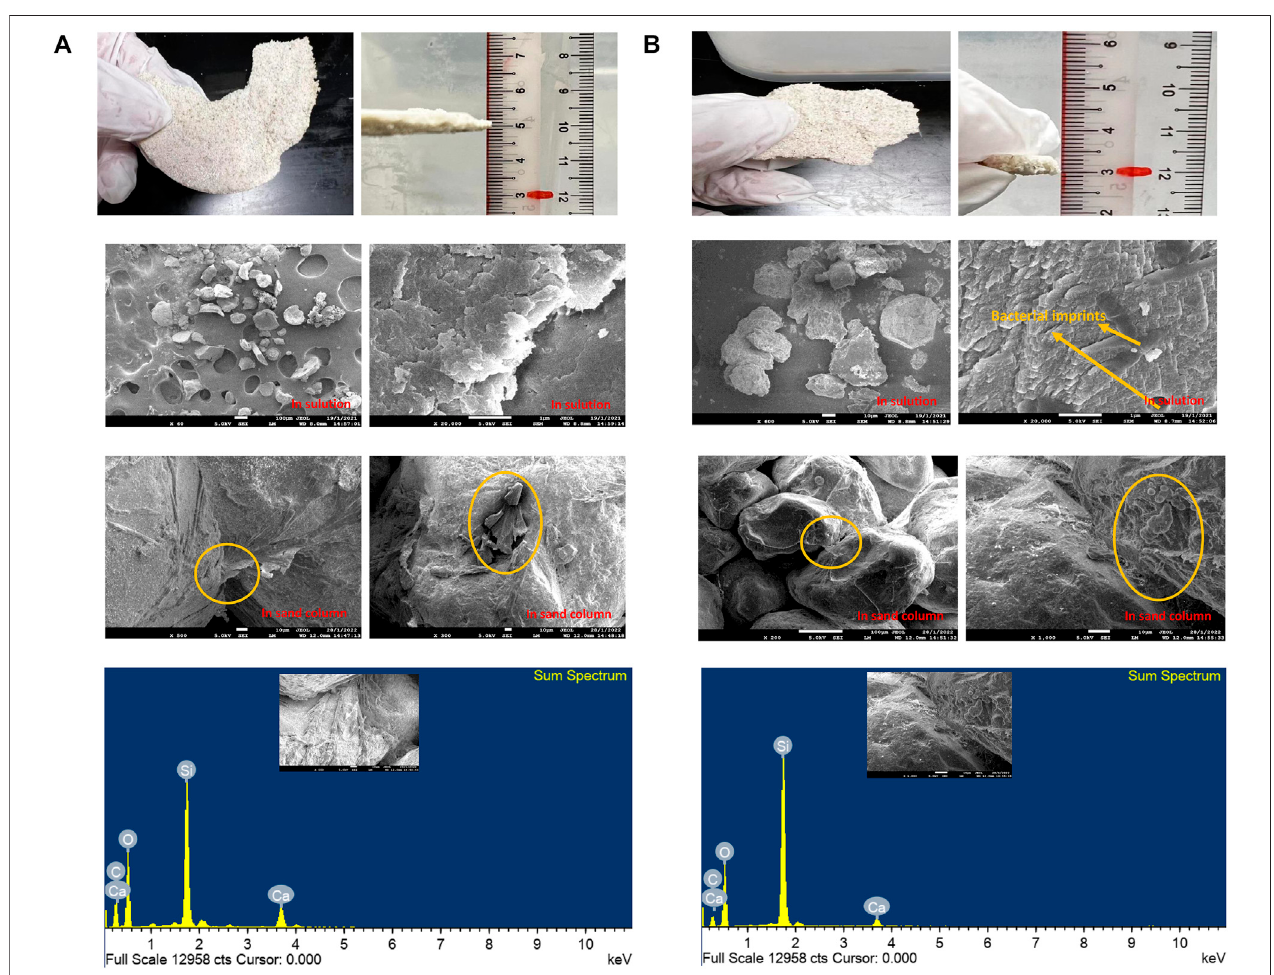
FIGURE 4 | FESEM images of the microbial carbonized samples using (A) Streptomyces micro fl avus ; (B) Paenibacillus mucilaginosus .